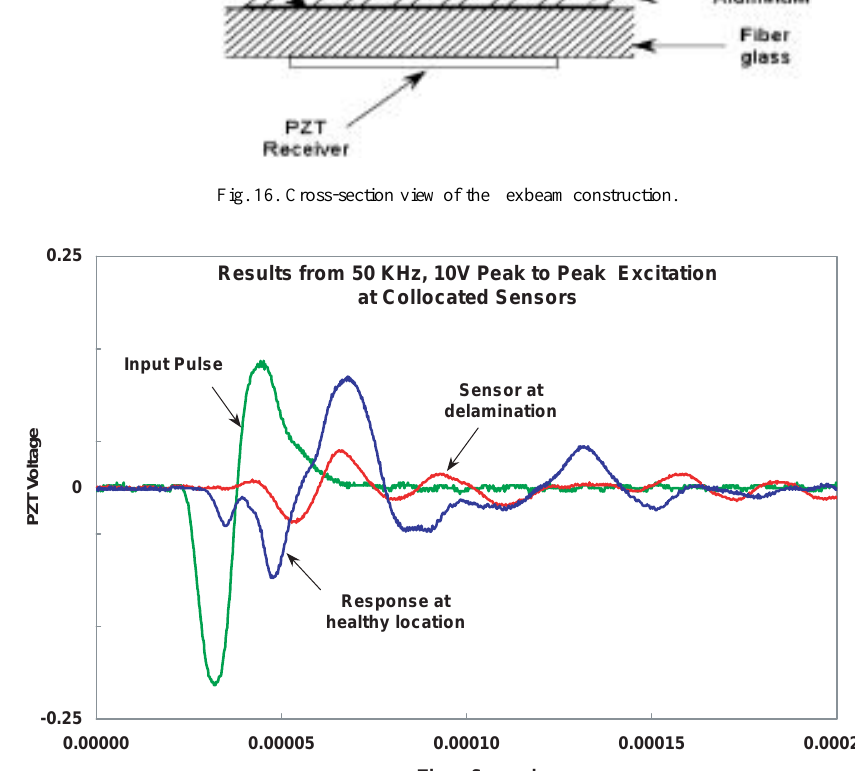
Fig. 17. Input, healthy, and damage time responses of the flexbeam for a 50 kHz sinusoidal burst